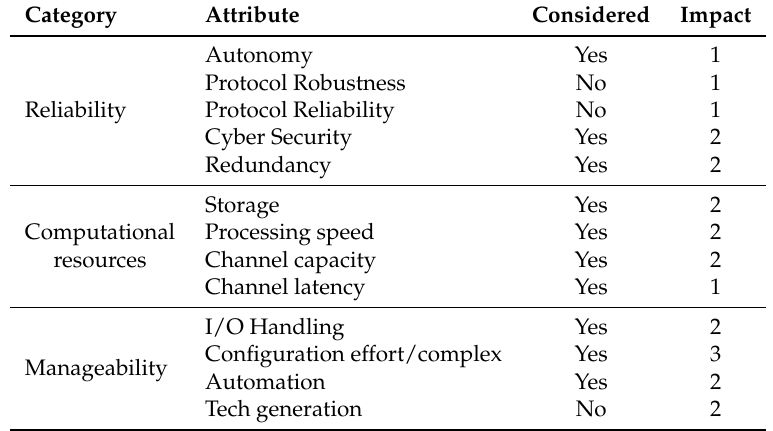
Table 6. Attributes classification for the Large Customer Commercial VPP